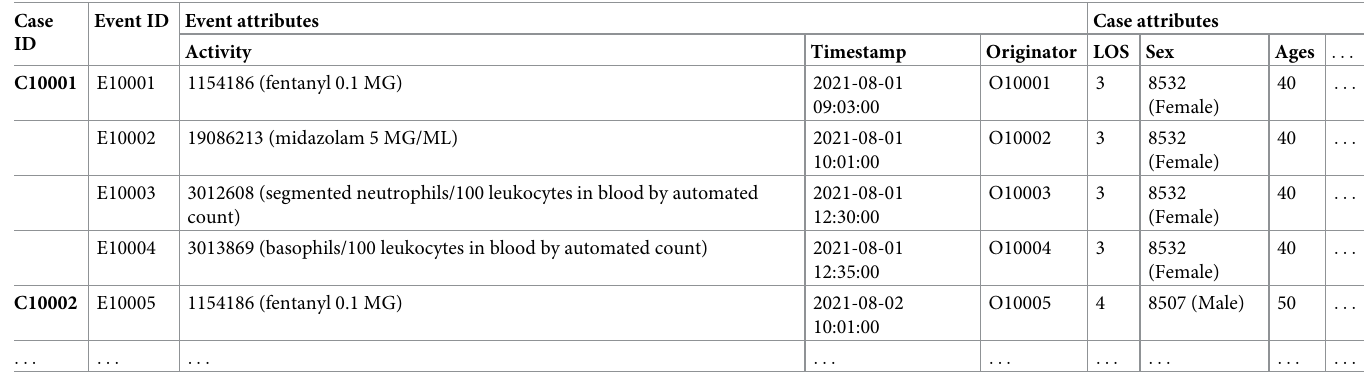
Table 1. An example of inpatient visit event